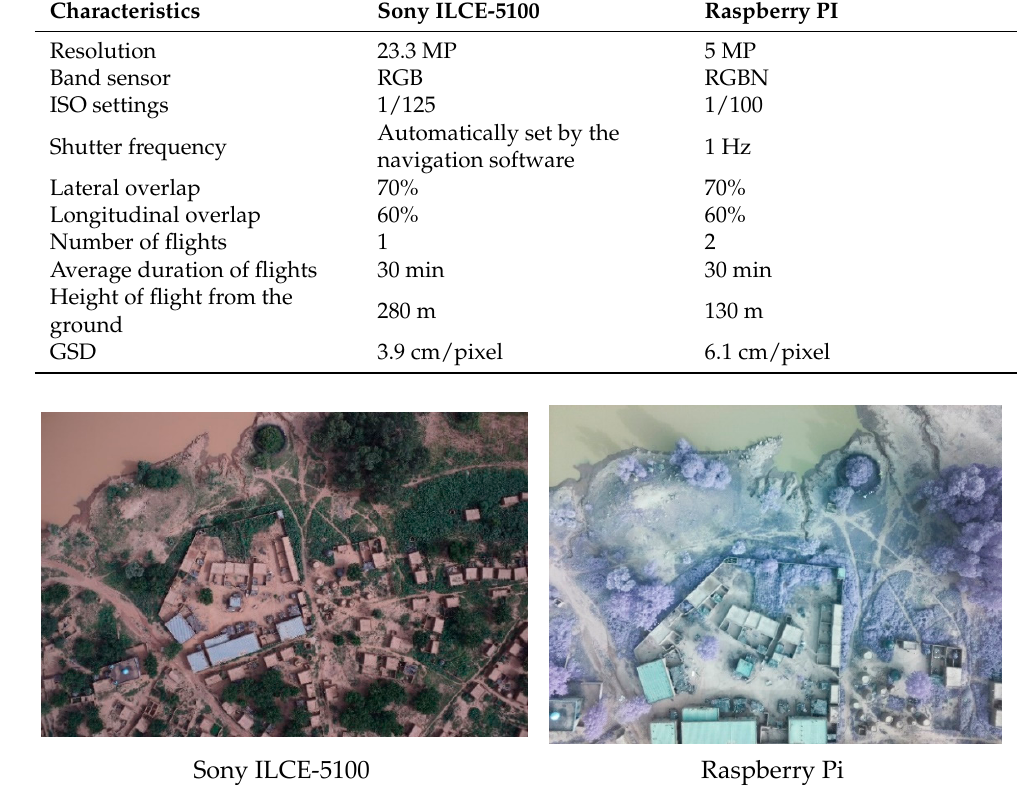
Figure 4. Sample pictures of the same area acquired by Sony ‐ ILCE ‐ 5100 and Raspberry Pi. The SONY picture (6000 × 3000 pixels) has a 3.9 cm/pixel resolution and is in RGB. The Raspberry picture (2592 × 1933 pixels) has a 6.1 cm/pixel resolution and is visualized in red ‐ green ‐ NIR false color composition.